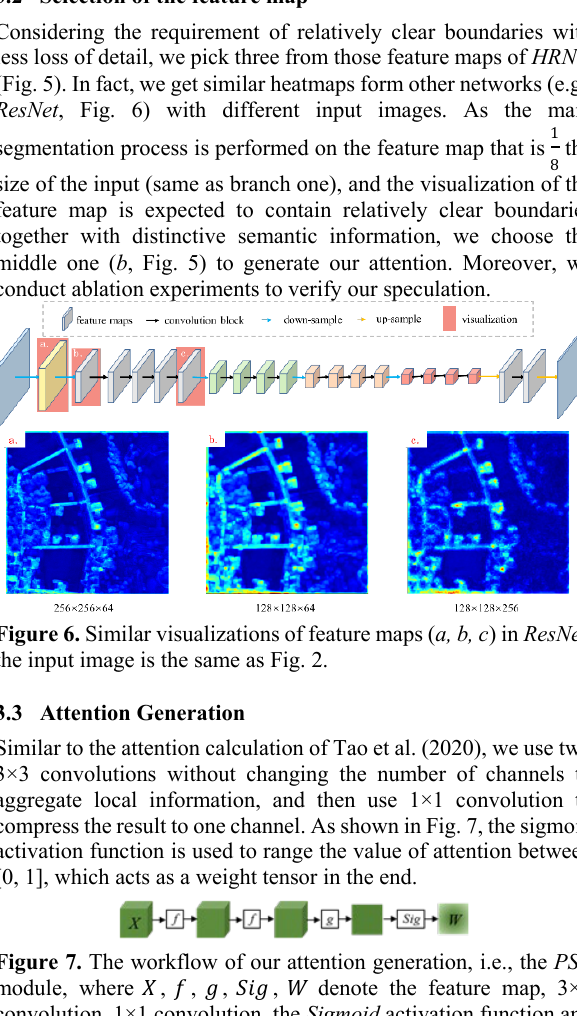
Figure 7. The workflow of our attention generation, i.e., the PSA